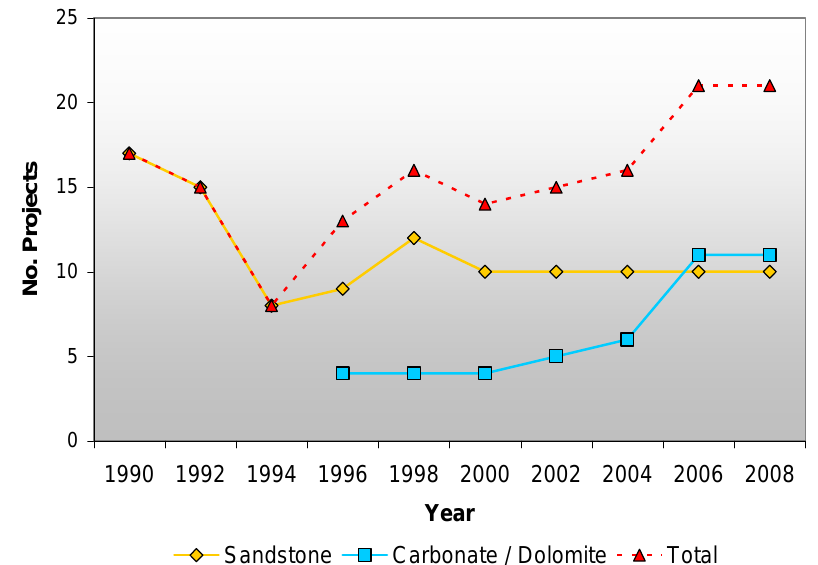
Figure 5. Trends in ISC and HPAI (From Moritis